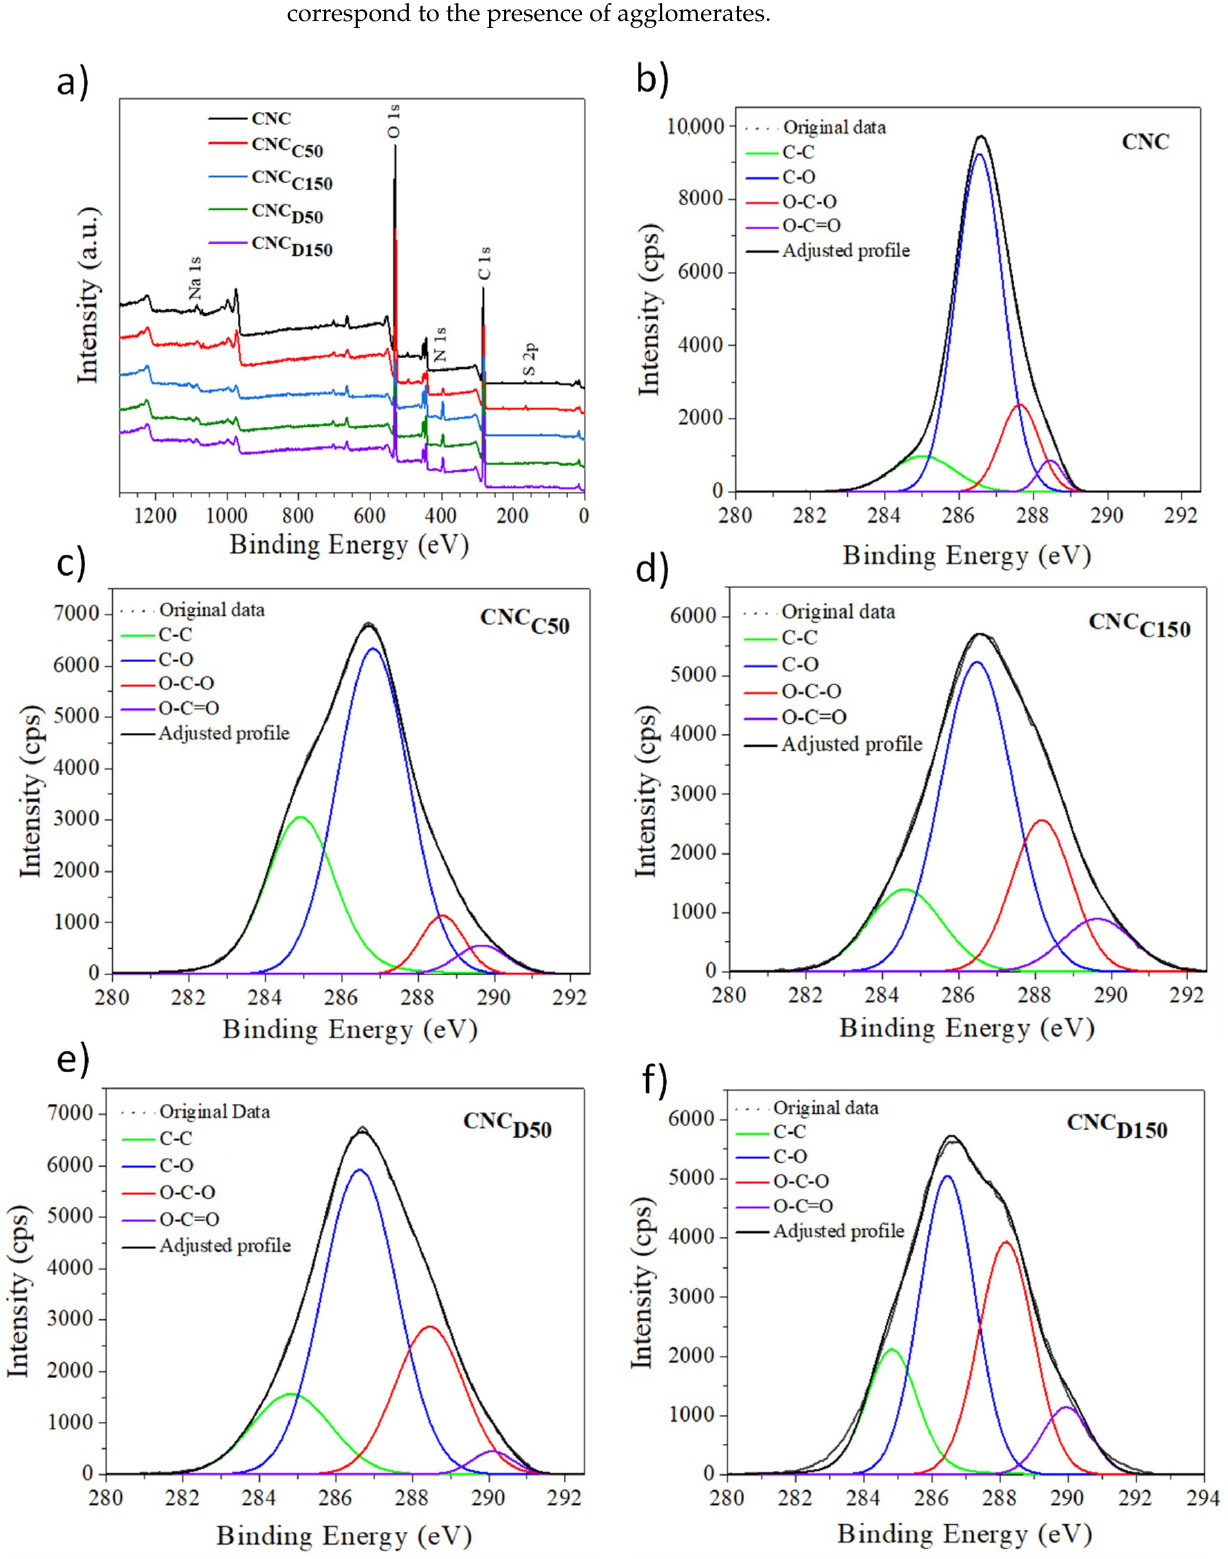
Figure 5. XPS survey ( a ), peak-fitted high-resolution of C 1s XPS spectra of the pristine ( b ) and modified CNCs ( c – f Table 4. Surface composition of pristine and modified CNCs calculated by XPS and the C 1s high-resolution data.